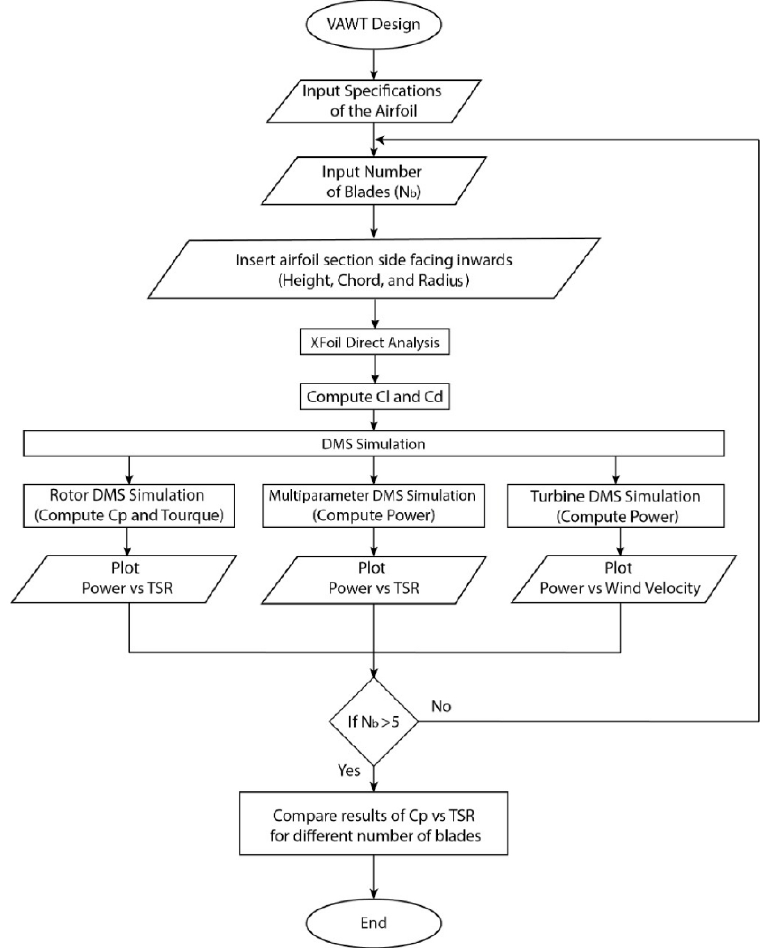
Figure 2. Flowchart of the developed approach to analyze and optimize the vertical axial wind tur- bine.